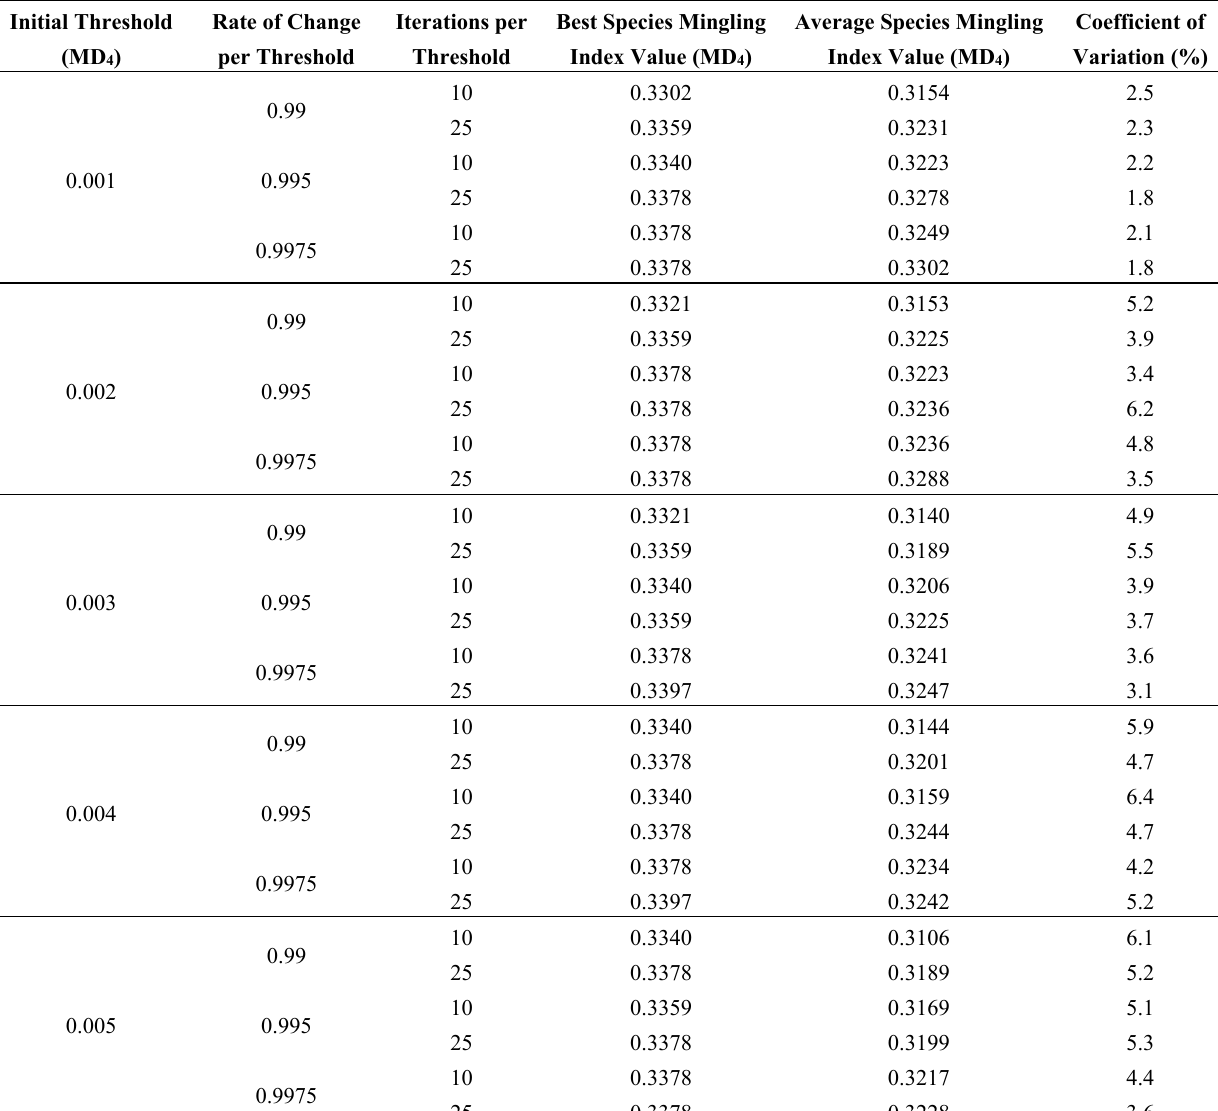
Table 4. Results of the application of threshold accepting to a tree-level harvest schedule of an uneven-aged oak-hickory stand in Georgia (eastern United States), based on maximizing the species mingling index and using unique oak tree species as